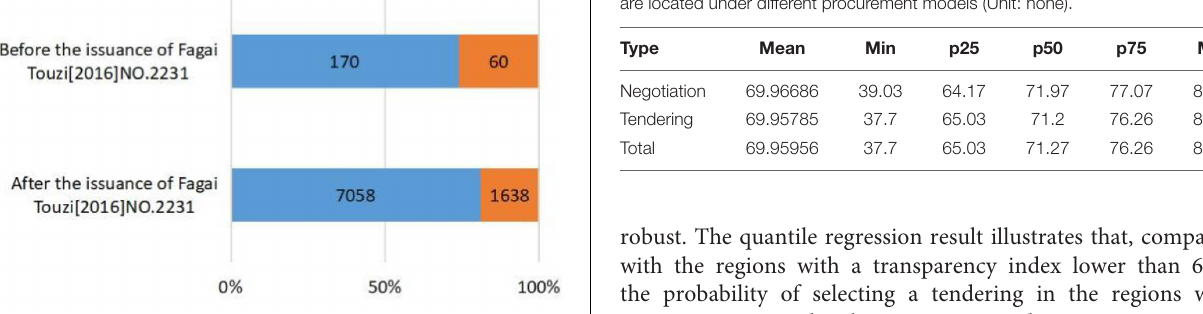
TABLE 3 | Descriptive statistics of transparency in provinces where PPP projects are located under different procurement models (Unit: none).